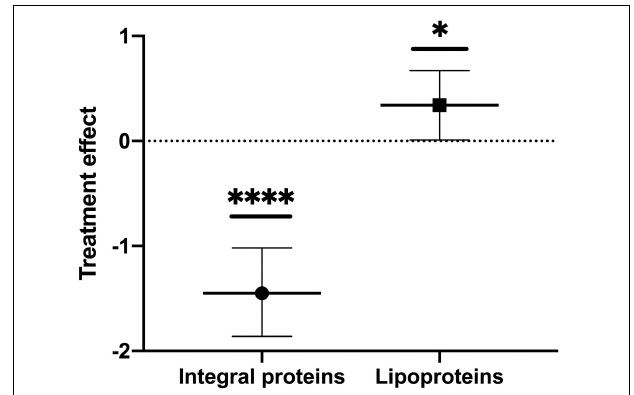
FIGURE 1 | Oxidative stress causes a preferential export of lipoproteins into OMVs and a preferential retention of integral proteins in the OM of ETEC. Parameter values for the treatment effect on OMV packaging ratios were calculated for OMV(+):OM(+), and OMV(–):OM(–) to obtain the increase or decrease in protein packaging in OMVs due to treatment stress. Error bars are confidence intervals. P -values calculated from confidence intervals (treatment effect): ∗ p ≤ 0.05, ∗∗∗∗ p ≤